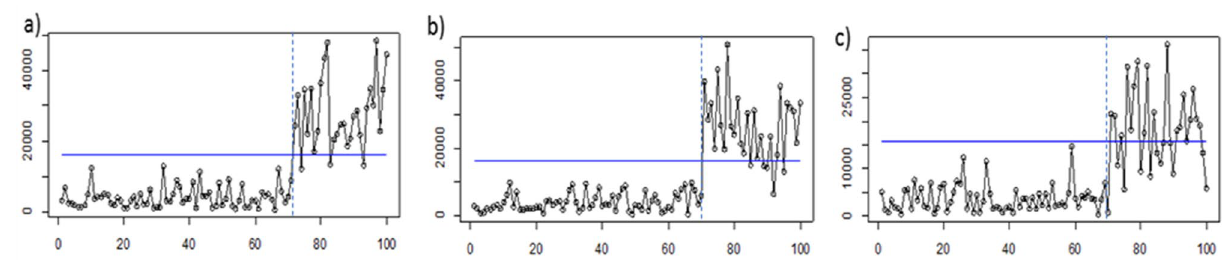
Figure 9. Application of the proposed Kernel PCA Mix chart with kernel Linear for: ( a ) the first scenario, ( b ) the second scenario, and ( c ) the third